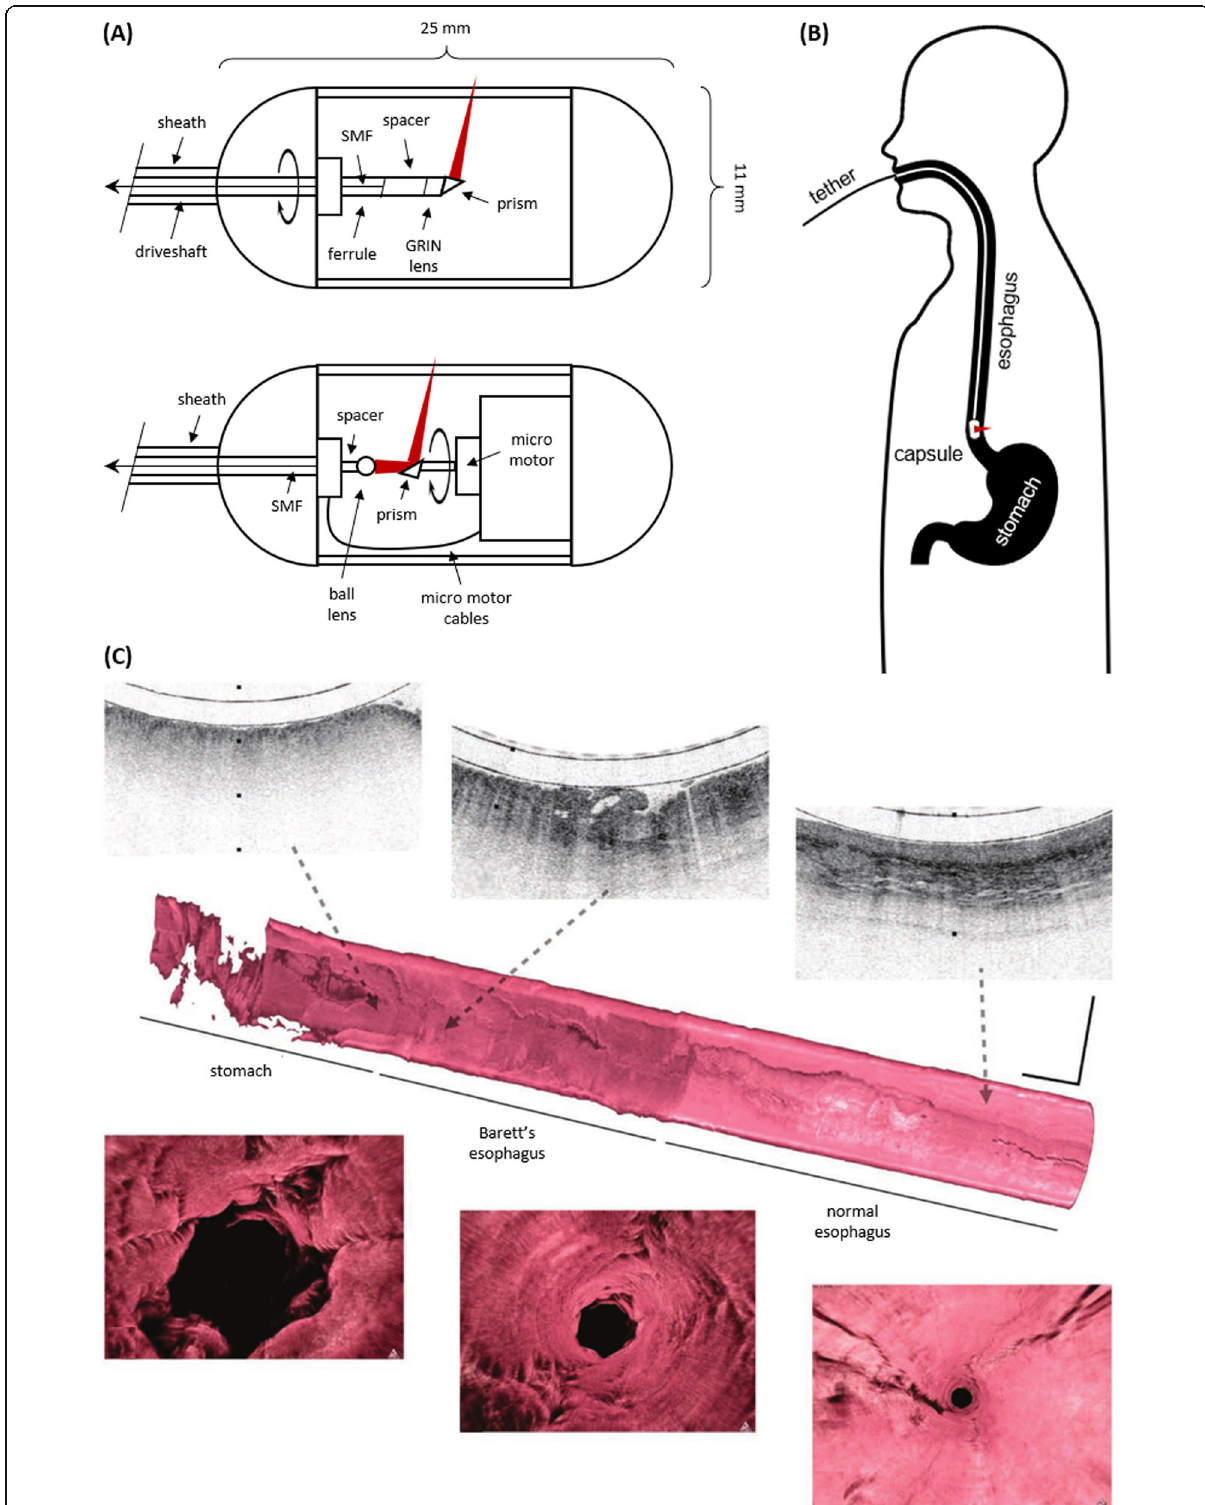
Fig. 7 (See legend on next